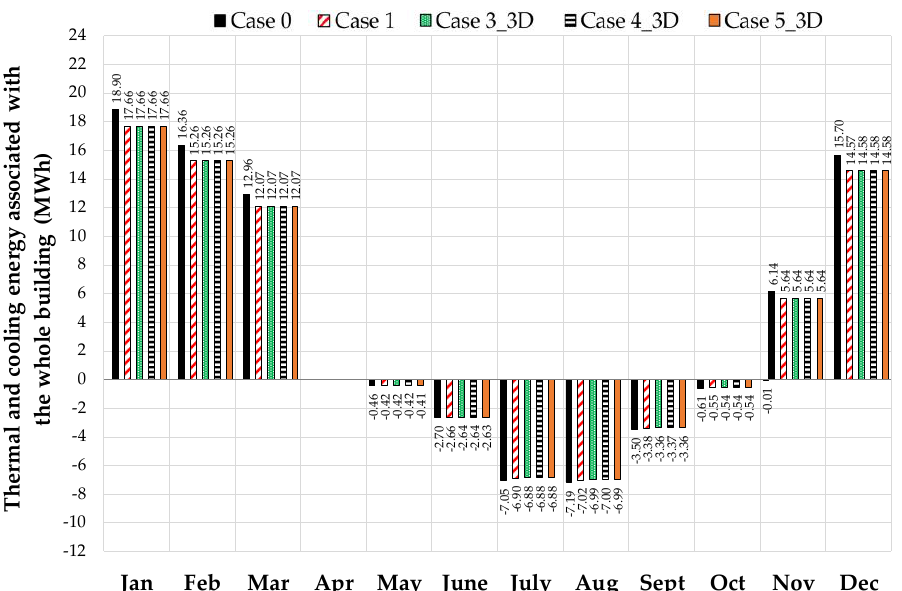
Figure 16. Main energy flows of the building during the whole simulation period associated with Case 0, Case 1, and retrofit Cases with 3D printed panels.